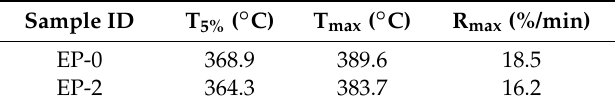
Table 3. TGA data of EP-0 and EP-2.